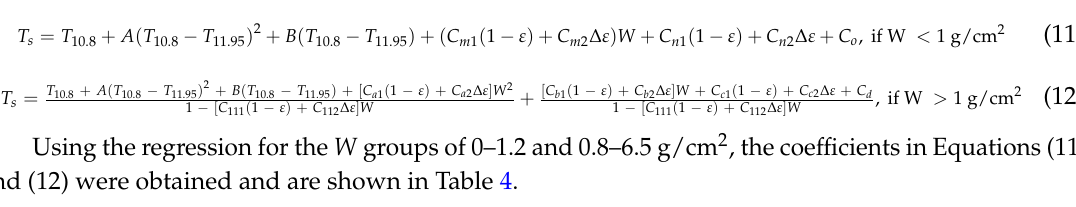
Table 4. Coefficients in Equations (11) and